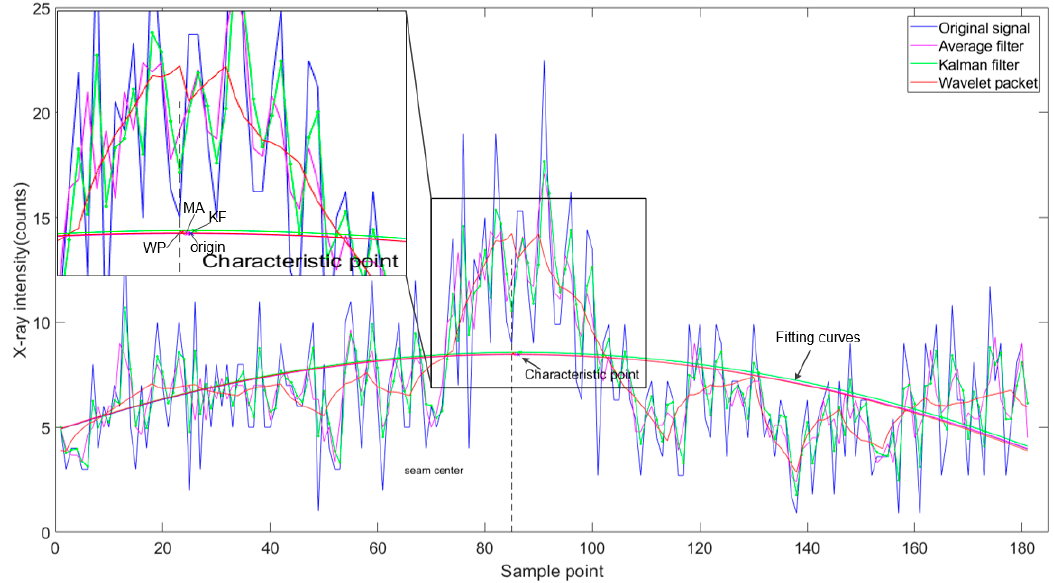
Figure 9. The curve fitting of some denoising algorithms.